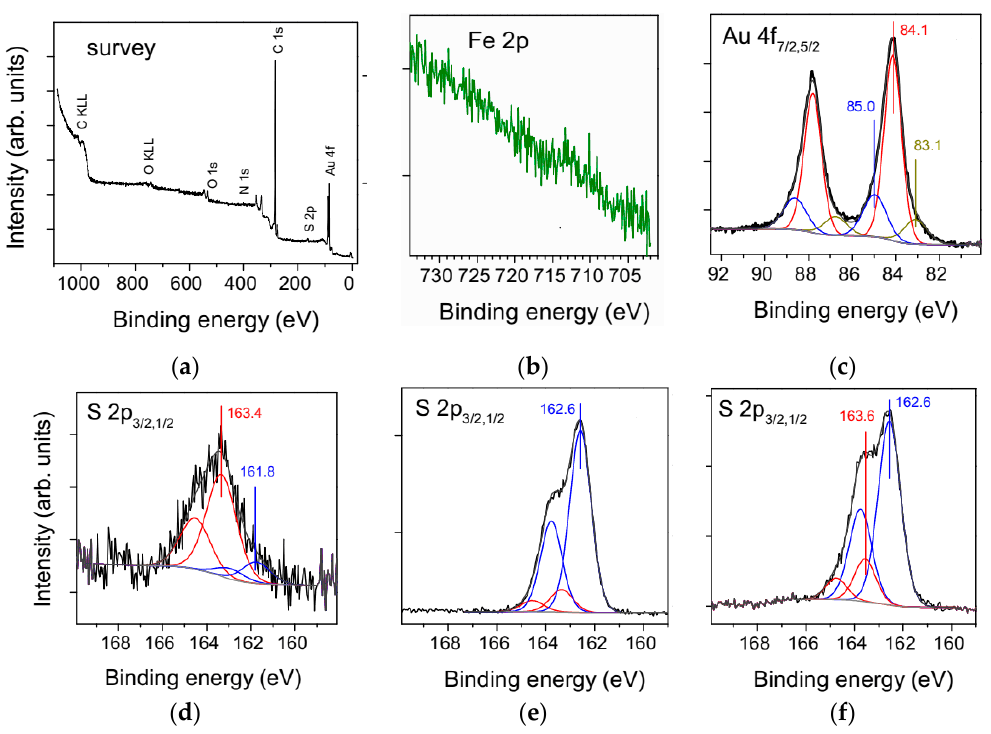
Figure 5. XPS spectra of the Au 4f, Fe 2p, S 2p, and O 1s photoelectron, respectively ( a – d ), for the gold-coated nickel ferrite nanoparticles synthesized under conditions in Figure 2 (three-stage coating), S2p spectra from the methionine ( e ) and the product of its interaction with aqueous AuCl 4 − complex ( f ). Table 1. Concentrations of main elements derived from XPS analysis. Sample Relative Concentrations (At. %)